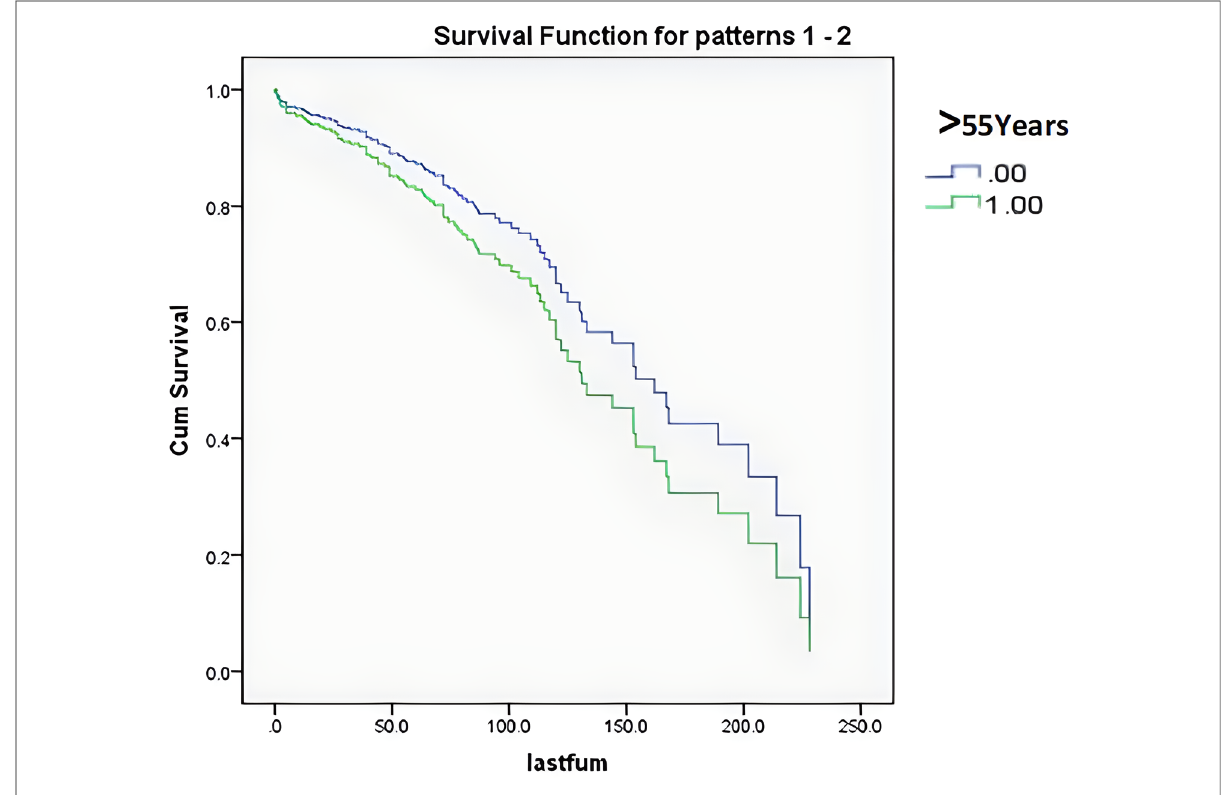
FIGURE 3 Survival curves of the patients discretized by age of 55